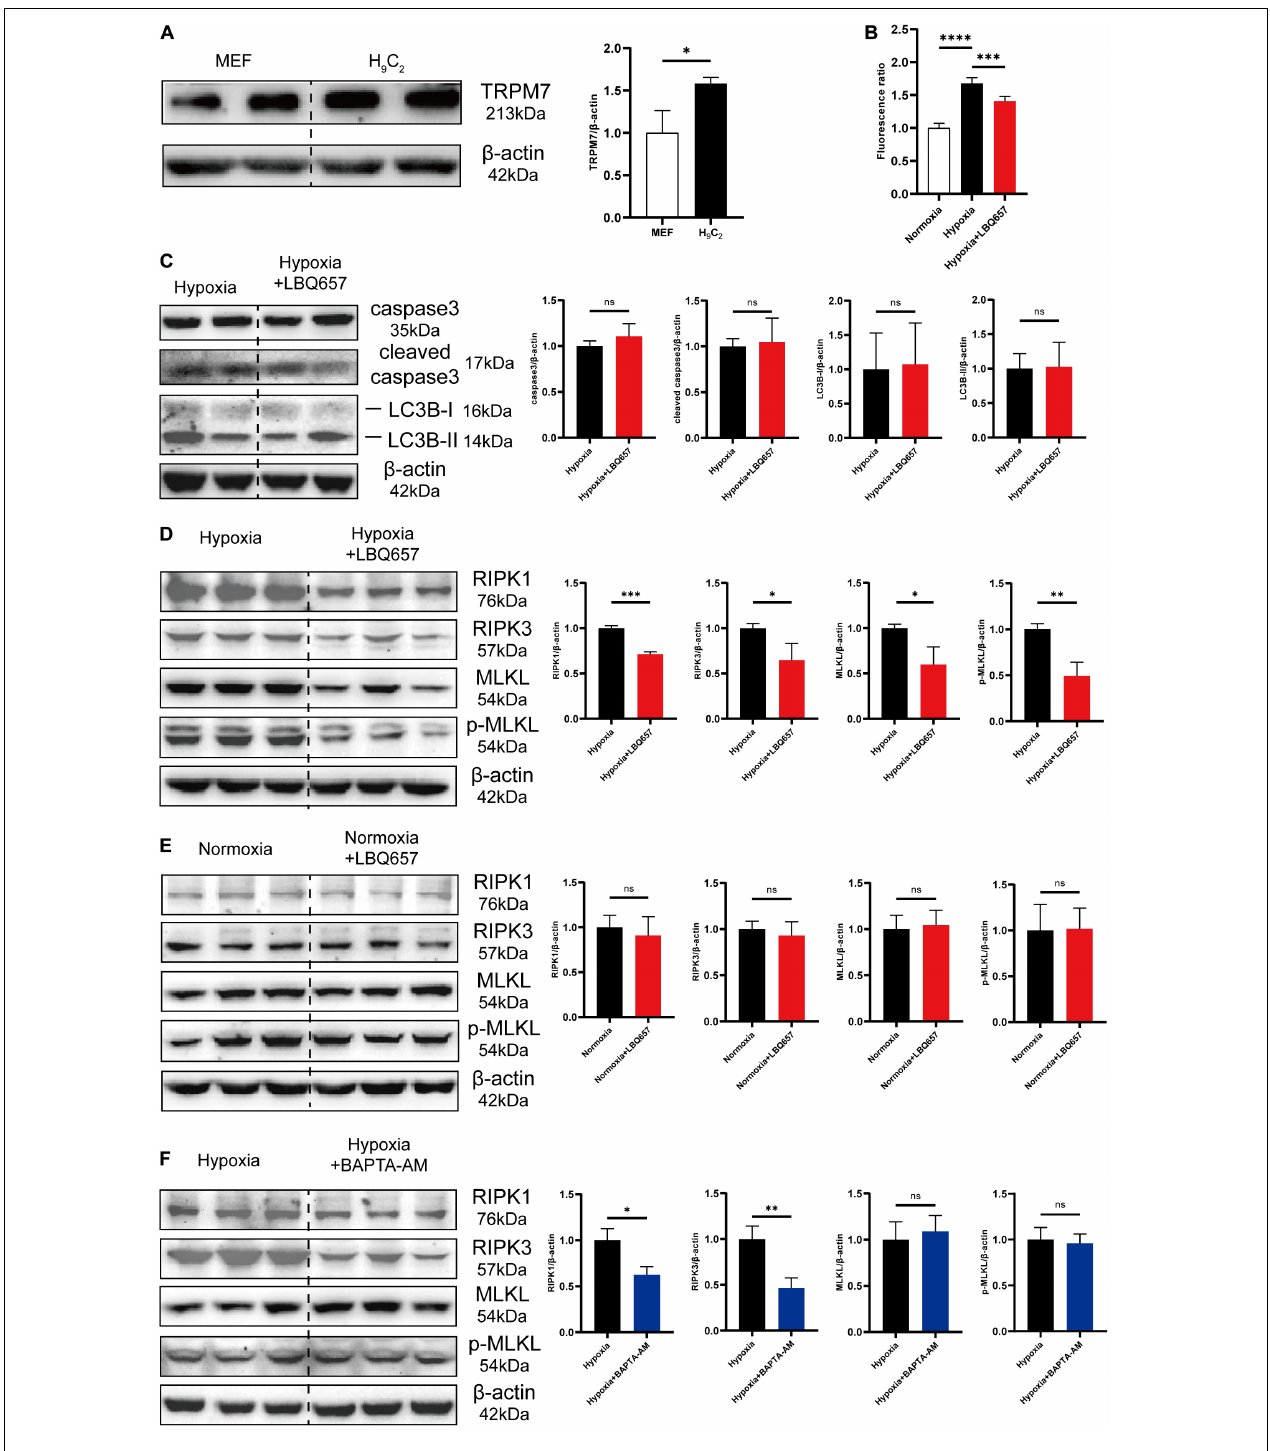
FIGURE 4 | LBQ657 reduced hypoxia-induced necrosis by inhibiting TRPM7-mediated Ca 2 + influx in cardiomyocytes. (A) Comparison of TRPM7 protein levels in MEF and H 9 C 2 cells. (B) Fluorescence intensity of Fluo-4-AM fluorescent dye in 488 nm excitation light of normoxic H 9 C 2 , hypoxic H 9 C 2 and hypoxic H 9 C 2 pre-treated with LBQ657. (C) Protein levels of caspase3, cleaved caspase3, LC3B-I and LC3B-II in hypoxic H 9 C 2 and hypoxic H 9 C 2 pre-treated with LBQ657. (D) Protein levels of RIPK1/RIPK3/MLKL/p-MLKL in hypoxic H 9 C 2 and hypoxic H 9 C 2 pre-treated with LBQ657. (E) Protein levels of RIPK1/RIPK3/MLKL/p-MLKL in normoxic H 9 C 2 and normoxic H 9 C 2 treated with LBQ657. (F) Protein levels of RIPK1/RIPK3/MLKL/p-MLKL in hypoxic H 9 C 2 and hypoxic H 9 C 2 pre-treated with BAPTA-AM. The data presented are mean ± SD. Each group contained the results of three independent repeated trials. β -actin was used as the internal reference protein for normalization and statistical analysis. ∗∗∗∗ P < 0.0001, ∗∗∗ P < 0.001, ∗∗ P < 0.01, and ∗ P < 0.05.